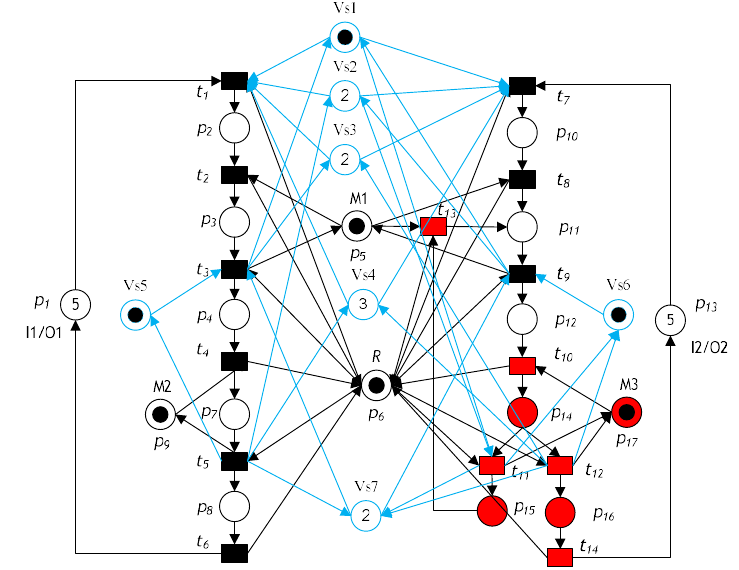
Figure 10. Controlled reconfigurable S 3 PR net by rework.